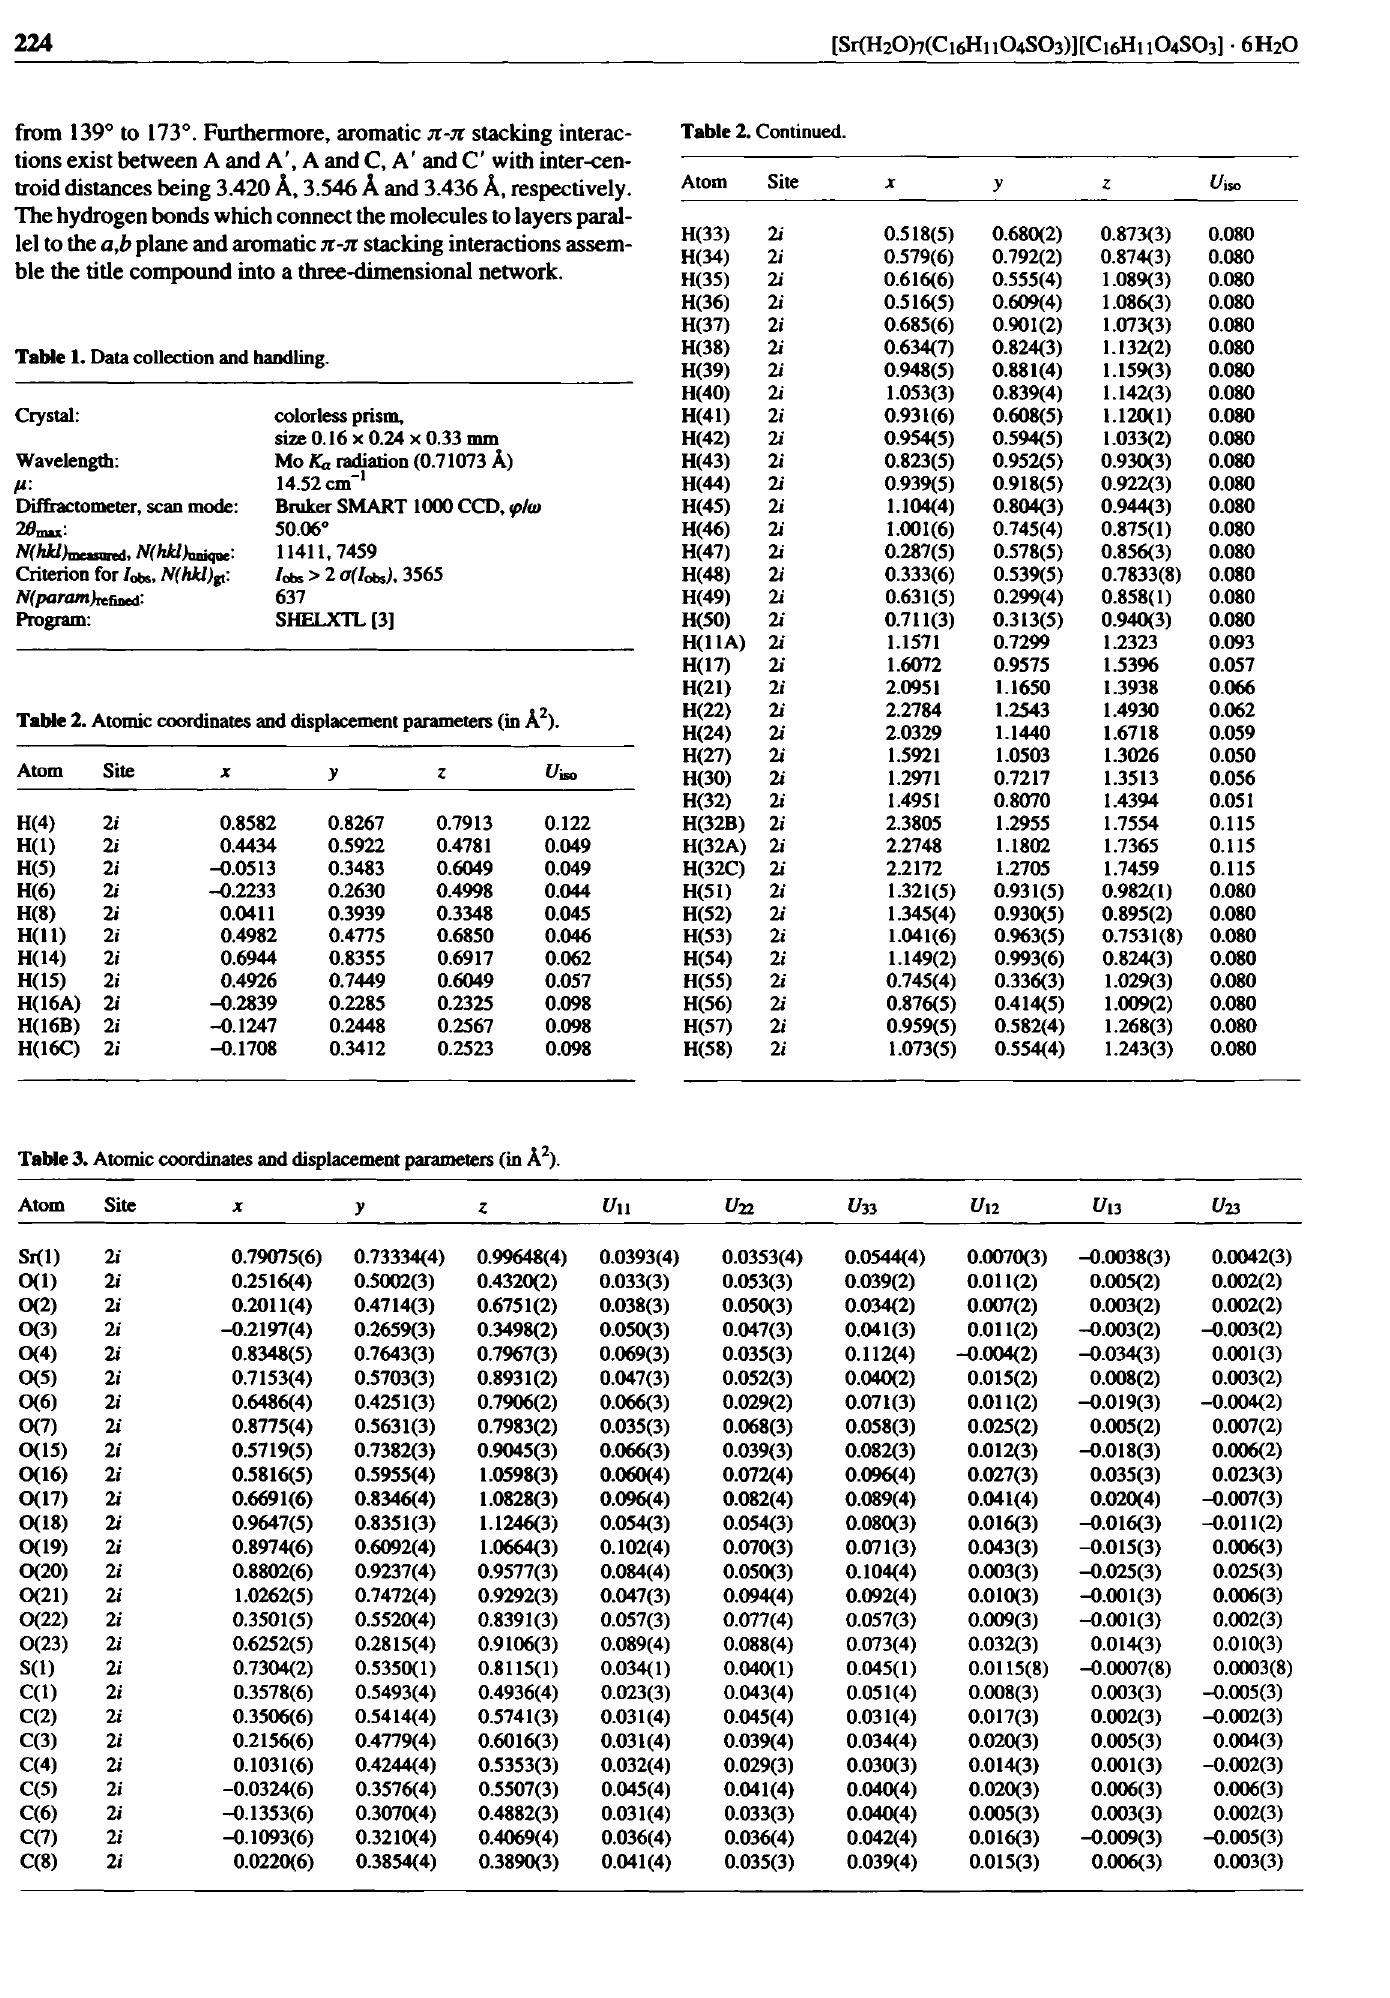
Table 3. Atomic coordinates and displacement parameters (in Ä 2